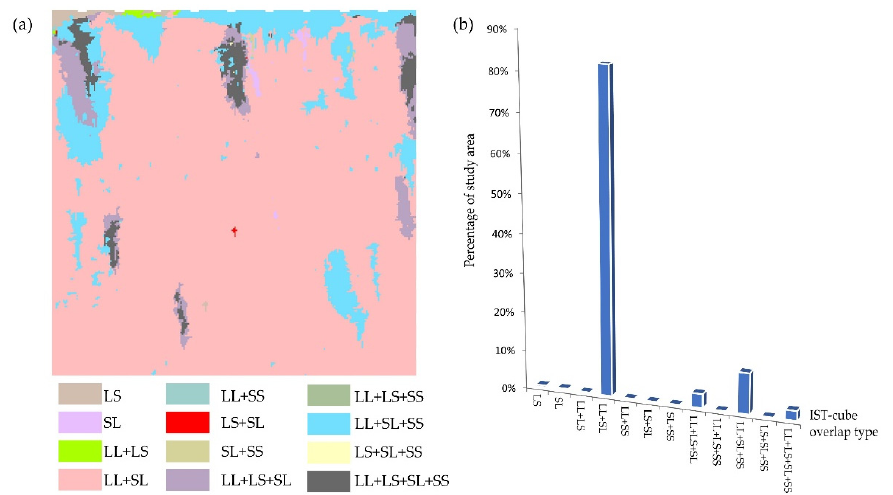
Figure 17. ( a ) Spatial distribution map of the overlap of different types of IST-cubes. ( b ) Different types of IST-cubes overlap areas as a percentage of the total study area.